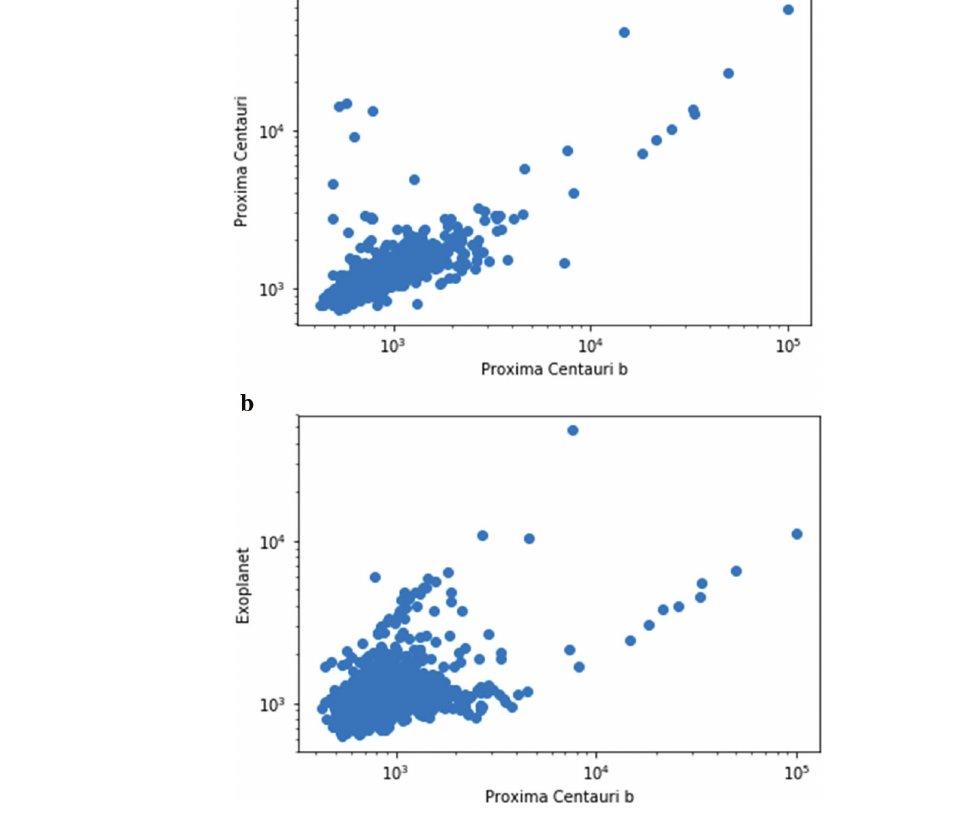
Figure 6. Viewing figures for Wikipedia articles – (a) ‘Proxima Centauri’ and (b) ‘Exoplanet’ – plotted against the viewing figures for the article ‘Proxima Centauri b’, taken on the same day (Source: Authors,